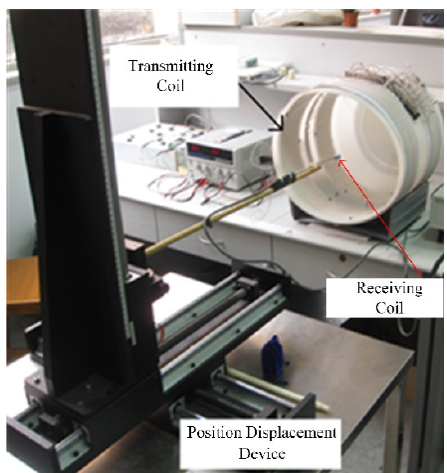
Figure 3. Setup for measuring mutual inductance when the receiving coil (RC) is in different positions.